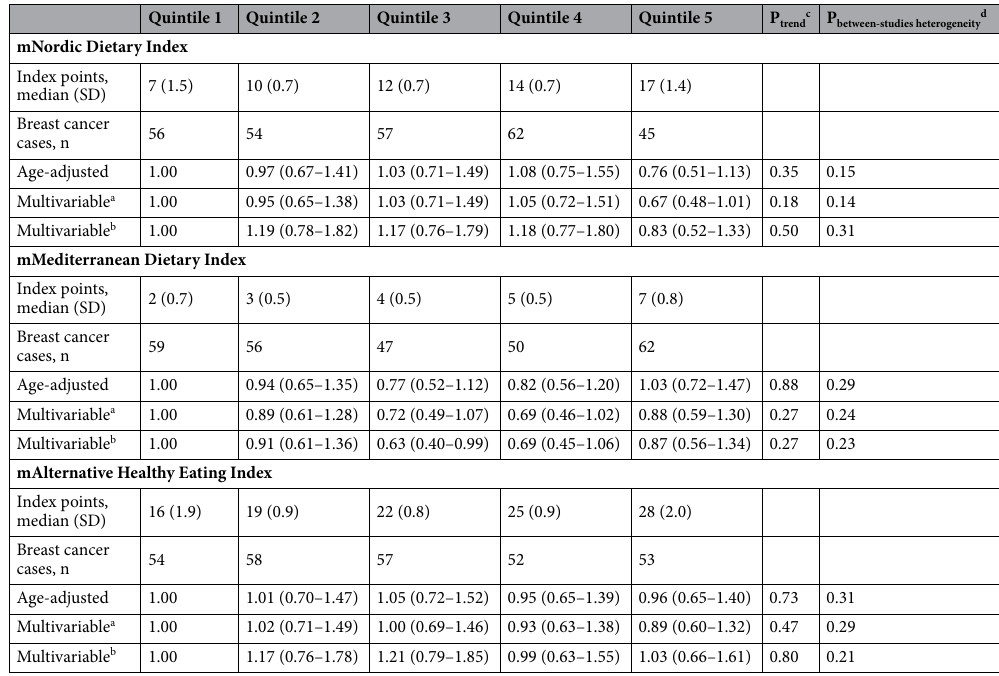
Table 3. Hazard ratios (HR) and confidence intervals (95% CI) of postmenopausal breast cancer by quintiles of dietary indices. a Multivariable model was adjusted for age (years), education (tertiles by birth year), smoking (never, former, current smokers), height (cm, continuous), body mass index (kg/m 2 , continuous), leisure time exercise (passive, somewhat active, active), parity (never, ever), hormone replacement therapy (never, ever), energy intake (kJ/day, continuous) and cohort. b Excluding cases diagnosed during the first two years of follow-up: Finnish Mobile Clinic Follow-up Survey (n = 5), Health 2000 (n = 19), Helsinki Birth Cohort (n = 8), FINRISK 2007 (n = 8) and FINRISK 2012 (n = 13). c P trend value, two-sided test calculated using a continuous variable based on the median in each quintile. d Multivariable model a excluding ‘cohort’ as a confounding factor.